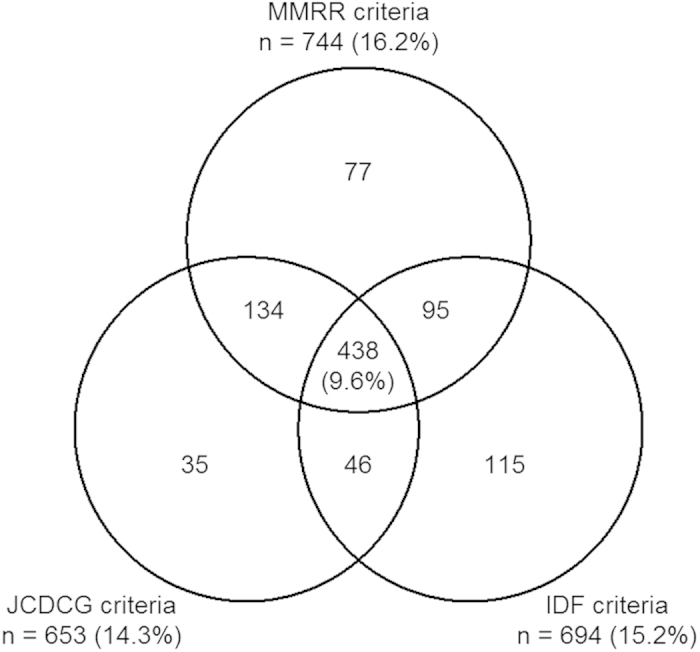
Overall crude prevalence and overlap of metabolic syndrome (MetS) by the JCDCG, MMRR, and IDF criteria among Shantou adults.